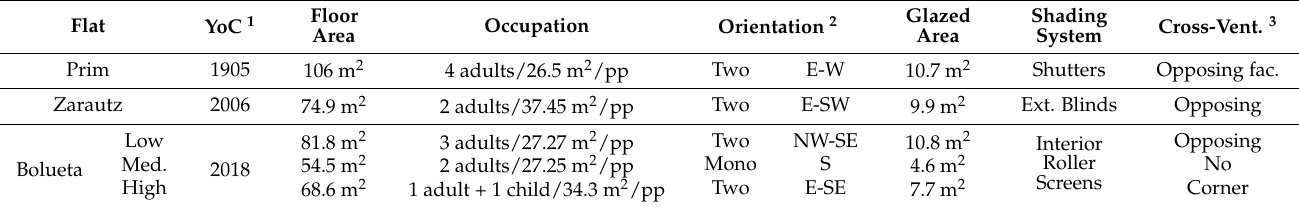
Table 2. Summary of characteristics of the studied dwellings.